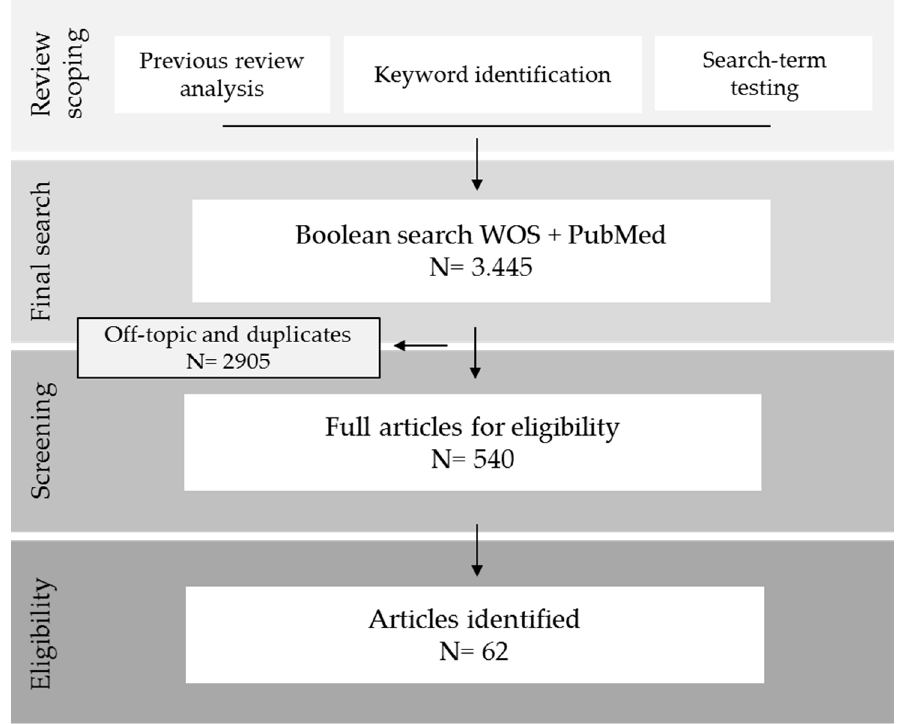
Figure 1. Flow diagram of article selection for the systematic review.